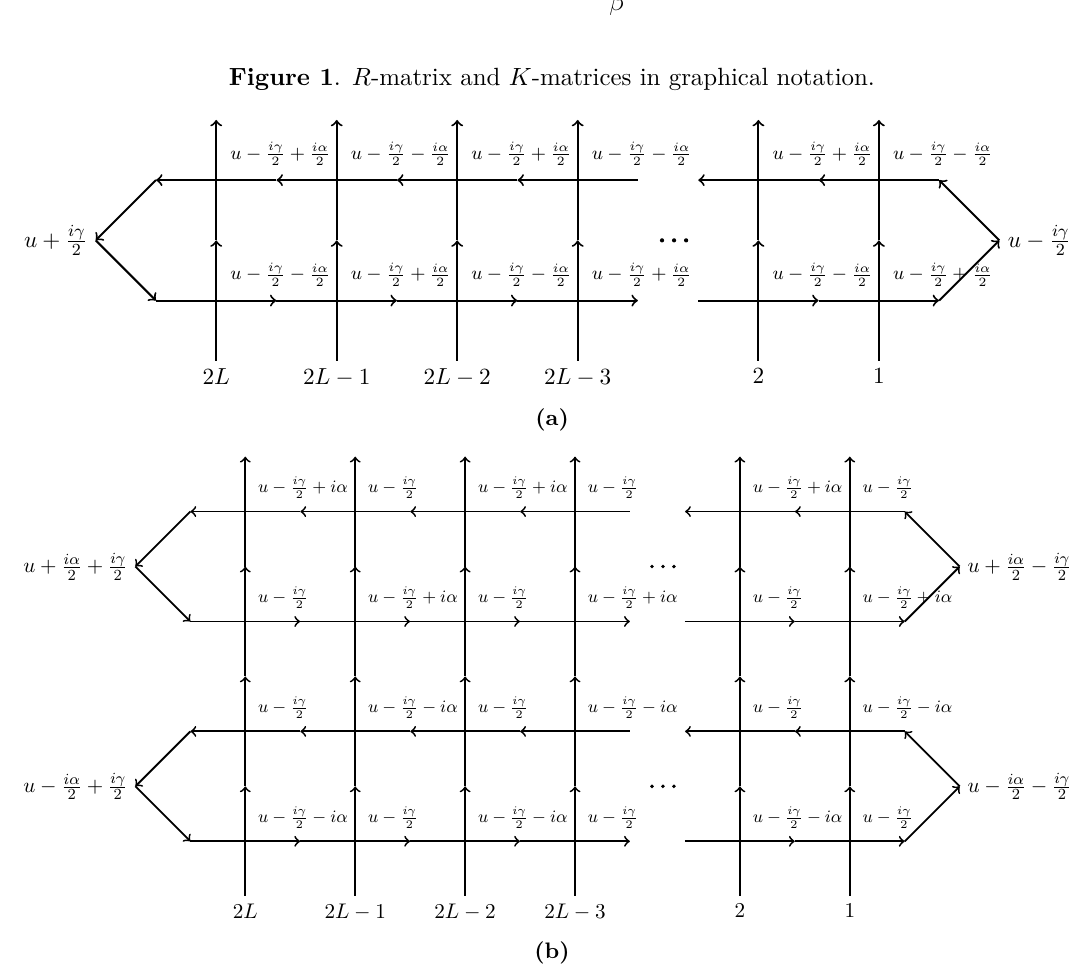
Figure 2 . (a) The double row transfer matrix τ ( u ) . The horizontal lines correspond to the auxiliary space V 0 , while the vertical lines represent the quantum spaces V j as labeled underneath. (b) Graphical representation of the four-row transfer matrix T ( u ) with two auxiliary spaces. Observe the staggering in the horizontal and vertical